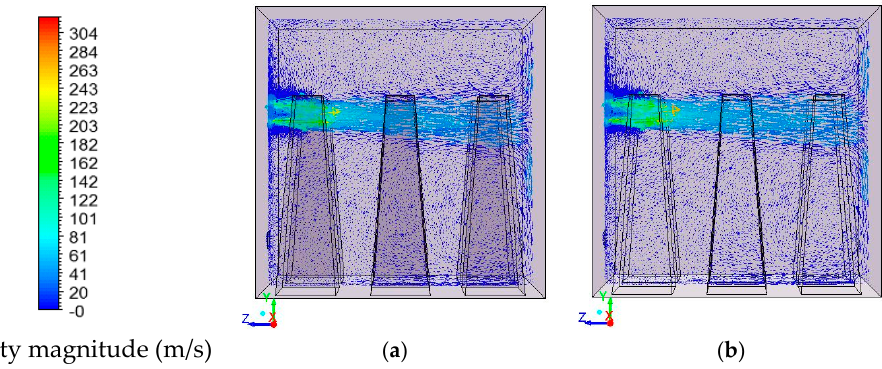
Figure 9. Velocity magnitude (m/s) profiles on a z - y surface in the middle of the furnace for selected cases: ( a ) Case 1 ( λ = 0.95); ( b ) Case 3 ( λ = 1.02). cases: ( a ) Case 1 ( λ = 0.95); ( b ) Case 3 ( λ =